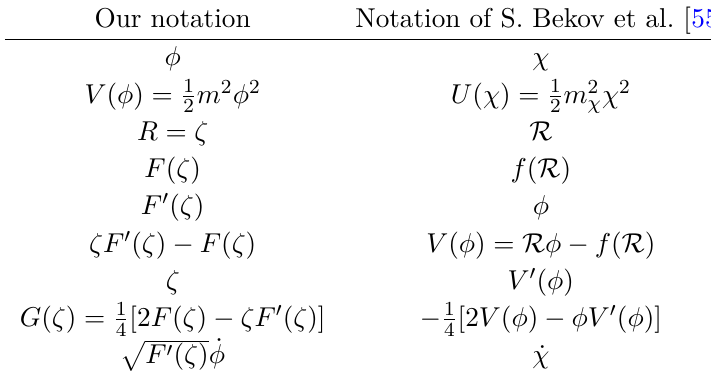
Table 1. A dictionary between the notation of this article and that of [55]. Note, in particular, the relation of the time derivatives: we use the Einstein frame time, whereas [55] works in the Jordan frame, leading to a difference related to the conformal factor F 0 ( ζ ) . We have set k ( φ ) = 1 , and worked in Planck units, M P ≡ κ − 1 = 1